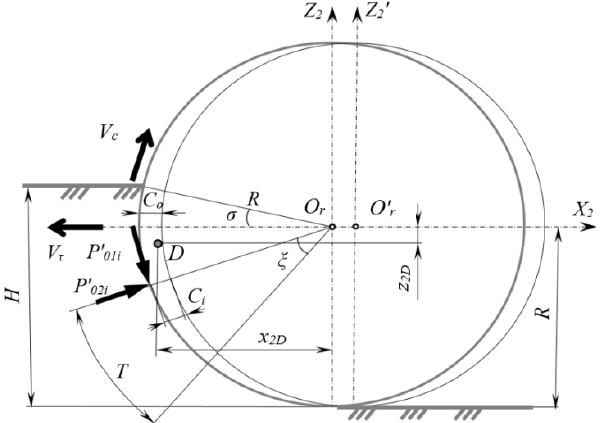
Figure 5. Calculation scheme for determining the resistance to frontal cutting of the soil with the rotor buckets.